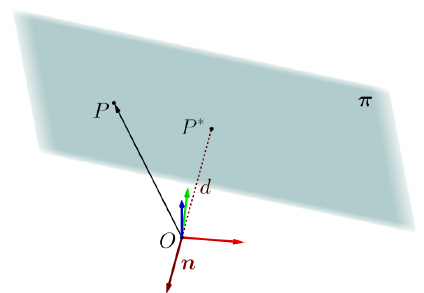
Figure 1: A plane π can be described in terms of a surface vector n of unit length and a scalar d which describes the shortest distance be- tween the origin O of the selected coordinate frame and the point P ∗ which is the point on π being the closest to O